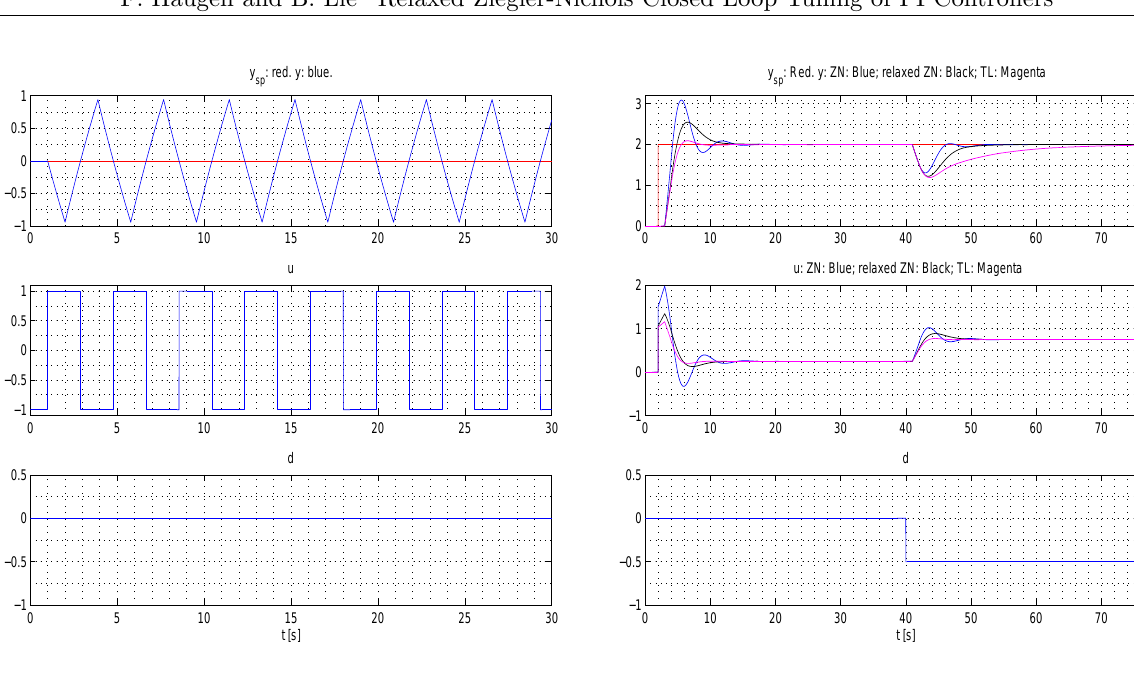
Figure 5: Responses with various PI